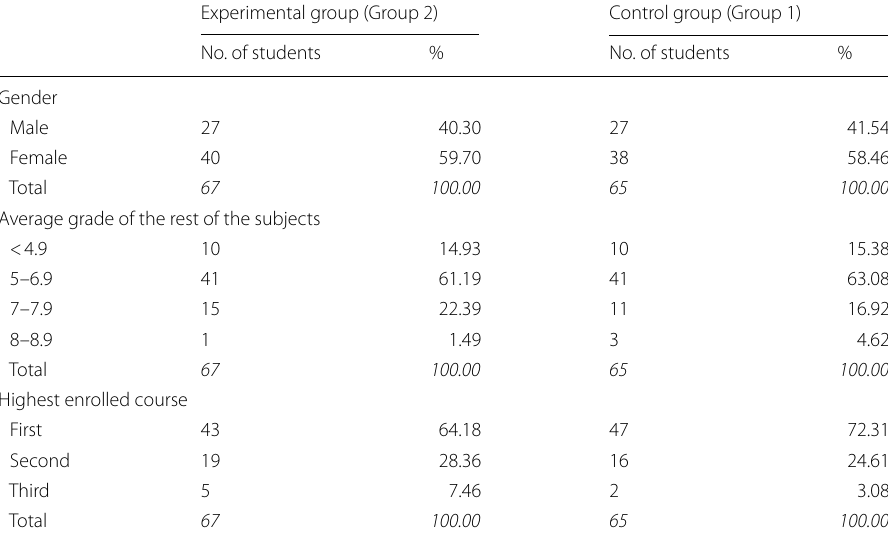
Table 2 Description of the experimental group and the control group Experimental group (Group